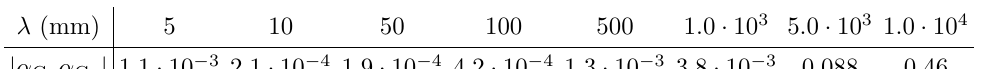
Table 5 . Constraints set by Eöt-Wash experiment [104] as a function of λ = 1 /m a .